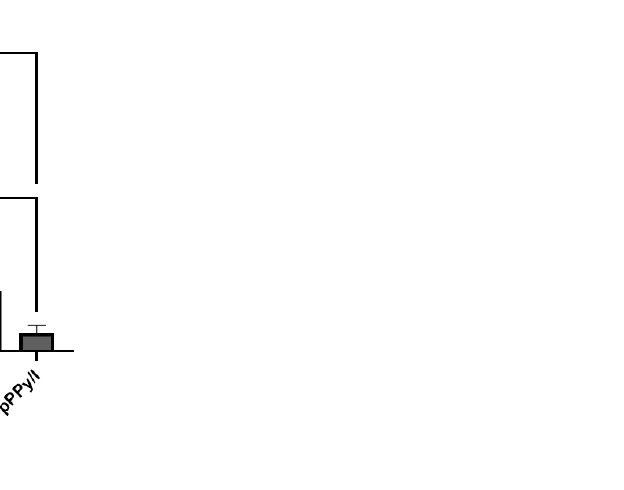
Figure 10. Porosity of scaffolds as-fabricated. Results presented as mean ± SD. Statistical differences with the ANOVA and Tukey multiple comparisons of means test, * p < 0.05, *** p < 0.001, **** p < 0.0001.